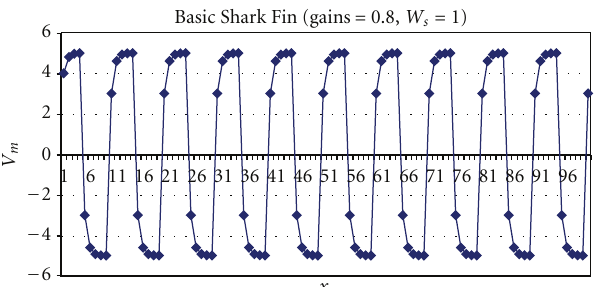
Figure 5: Output of the basic Shark Fin neural oscillator. Here the frequency of the waveform has been slightly more than doubled by doubling the gain